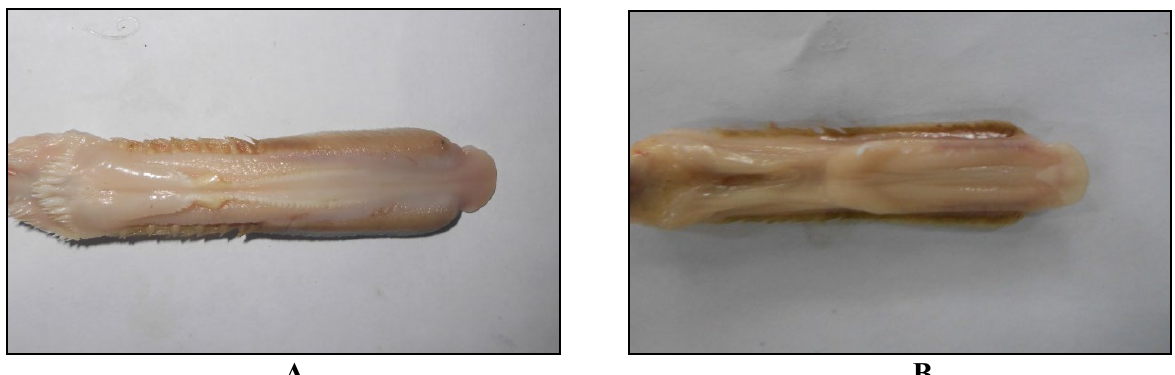
A B Fig. 5. Photograph of the dorsal (A) and ventral (B) surface of the tongue of the Khaki Campbell duck at three months of age